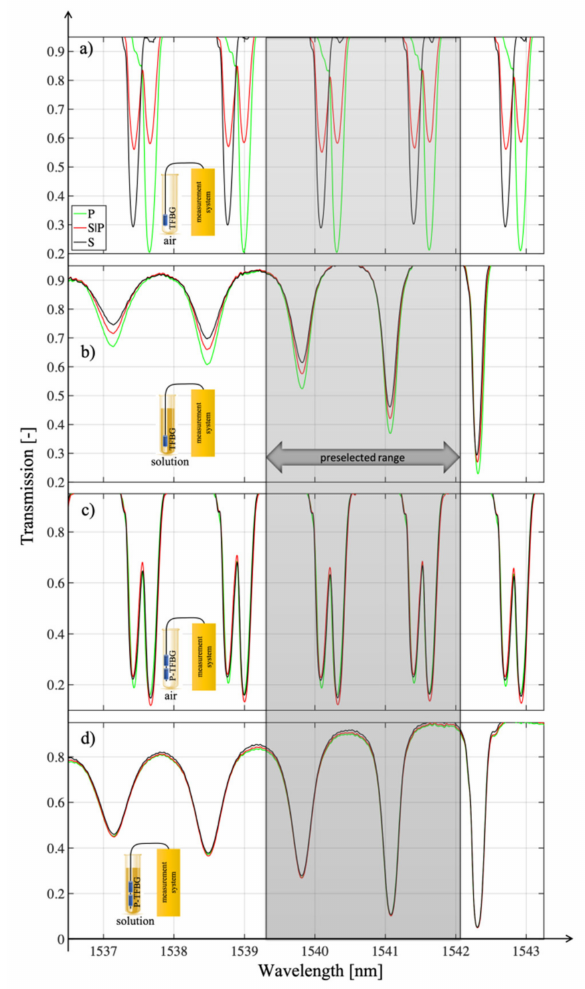
Figure 23. Measured spectral characteristics in the preselected range showing the response of the sensors to changes in P, S|P, and S polarization for the cases: ( a ) TFBG air, ( b ) TFBG solution,